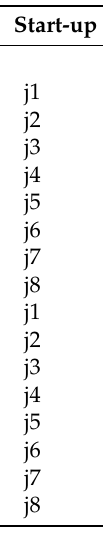
Table A5. Time steps on start-up cost curve of unit i (h) suc_sl( i , j ).